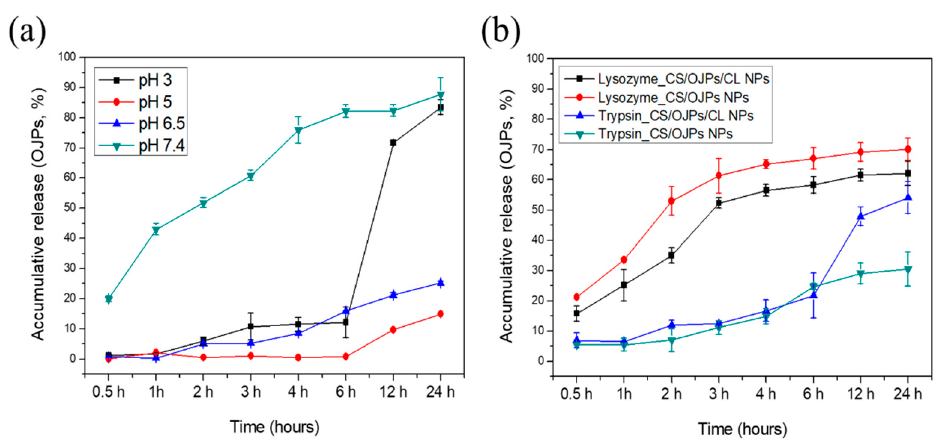
Figure 5. In vitro OJPs release from CS/OJPs and CS/OJPs/CL NPs: ( a ) OJPs release from the NPs at different pH conditions, ( b ) OJPs release from the NPs in pH 6.5 buffers containing lysozyme (1.0 mg/mL) and trypsin (0.5 mg/mL), respectively.